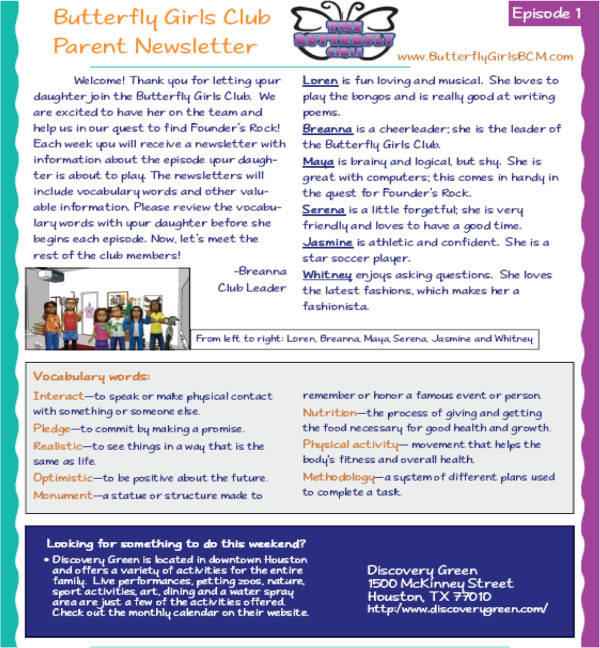
Parent newsletter.